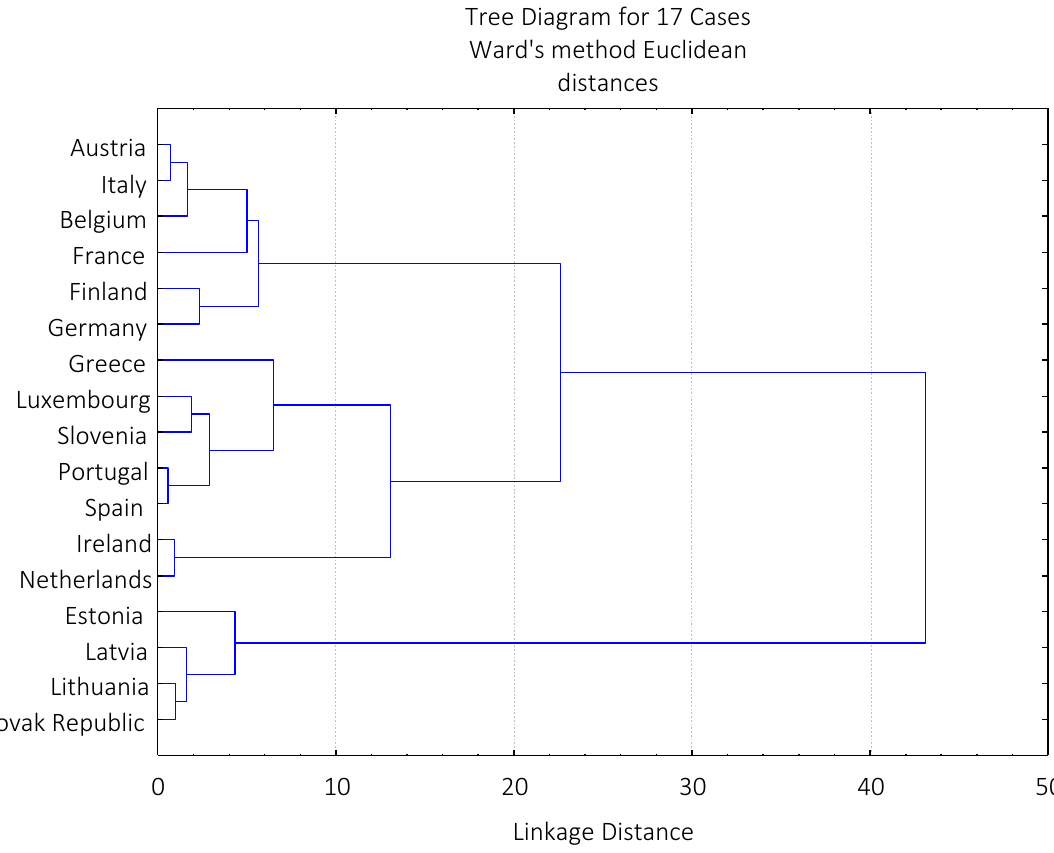
Figure 1. Country dendrogram for social spending and the Gini